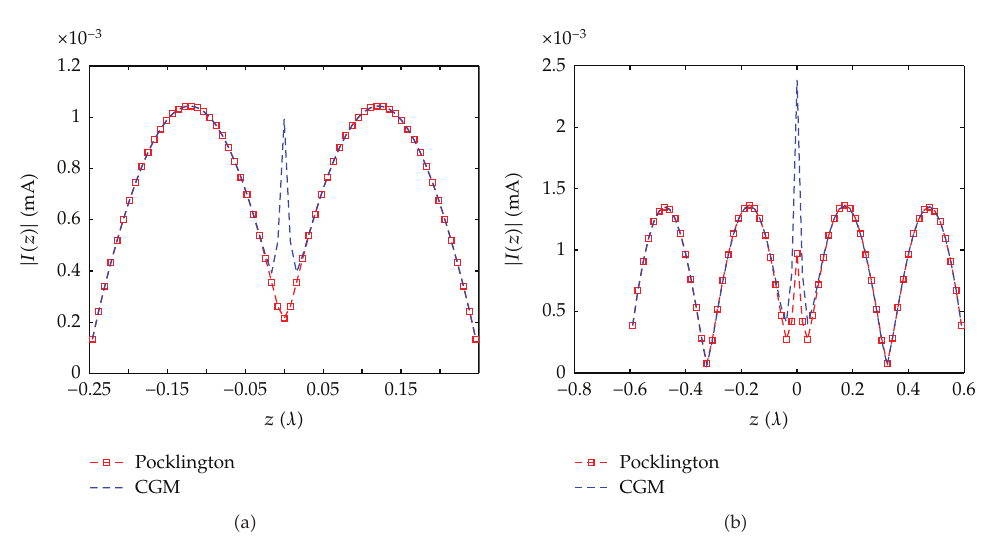
Figure 1: Current distributions: comparison of results for the MoM and CGM currents. On the left current distribution for a 0 . 5 λ length dipole antenna and on the right a current distribution for a 1 . 2 λ length dipole antenna.